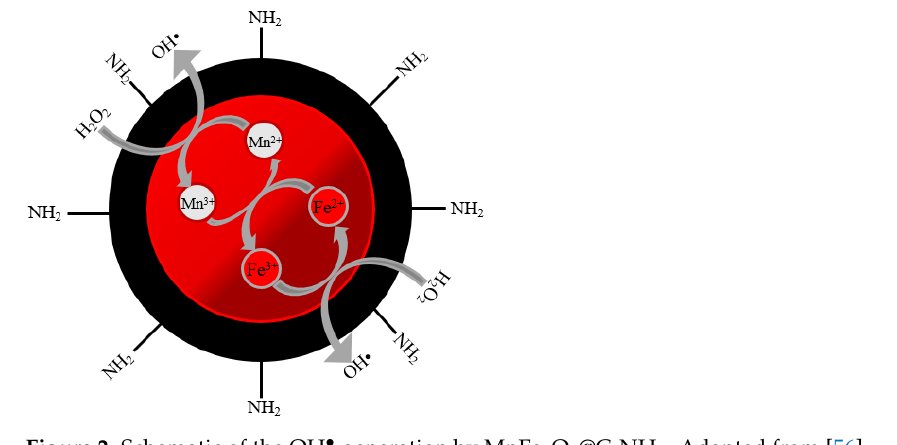
Figure 2. Schematic of the OH • generation by MnFe 2 O 4 @C-NH 2 . Adapted from [56]. Other antibiotics tested at pH 3 have been sulfamerazine (40 mg L − 1 ), sulfathiazole (0.5 mg L − 1 ), azithromycin (0.1 mg L − 1 ), norfloxacin (50 mg L − 1 ), and sulfamethoxazole (0.01 mg L − 1 ), with removal percentages >65%, using as Fenton catalysts, CNTs-Fe 3 O 4 (0.5 mg L − 1 ), dissolved iron from zero-valent iron nanoparticles (9 mg L − 1 ), MnFe 3 O 4 -HS (1000 mg L − 1 ), Fe 3 O 4 /Schwertmannita/carbon (50 mg L − 1 ) (Figure 3) and fresh powder from Fe 0 , respectively [57–61]. On the other hand, Hommem et al. [62] studied a range of pHs from 3.5 to 4.5, for the degradation of amoxicillin (0.45 mg L − 1 ) using FeSO 4 · 7H 2 O (0.095 mg L − 1 ) as catalysts, obtaining 100% degradation in all cases.